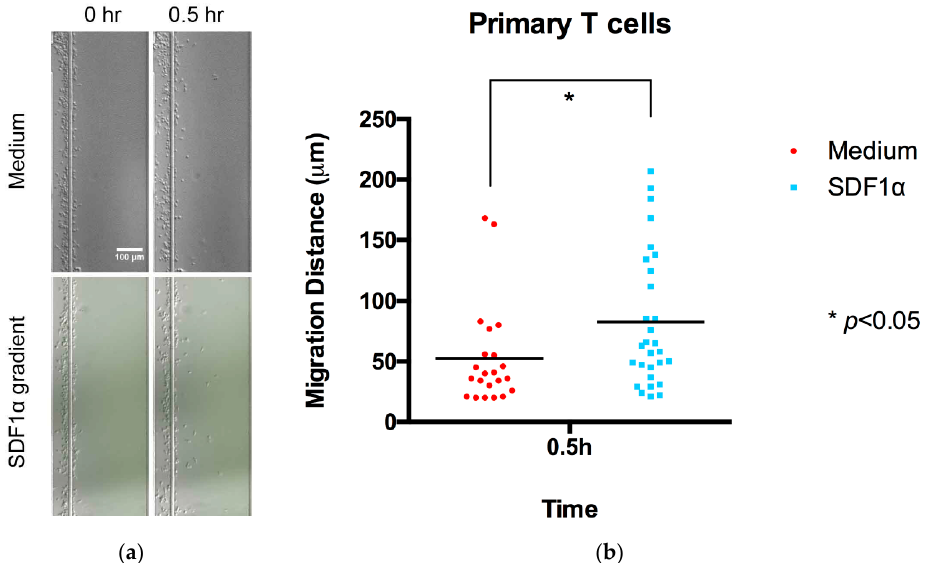
Figure 3. Chemotaxis of primary T cells in the radial microfluidic device. ( a ) Representative primary T cells distribution images in the channel at the beginning and the 0.5 h chemotaxis experiment in a 100 nM SDF-1 α gradient. ( b ) Quantitative migration distance analysis for the experiments in ( a ). The results are presented as the average value ± standard error of the mean (SEM). * indicates p < 0.05.